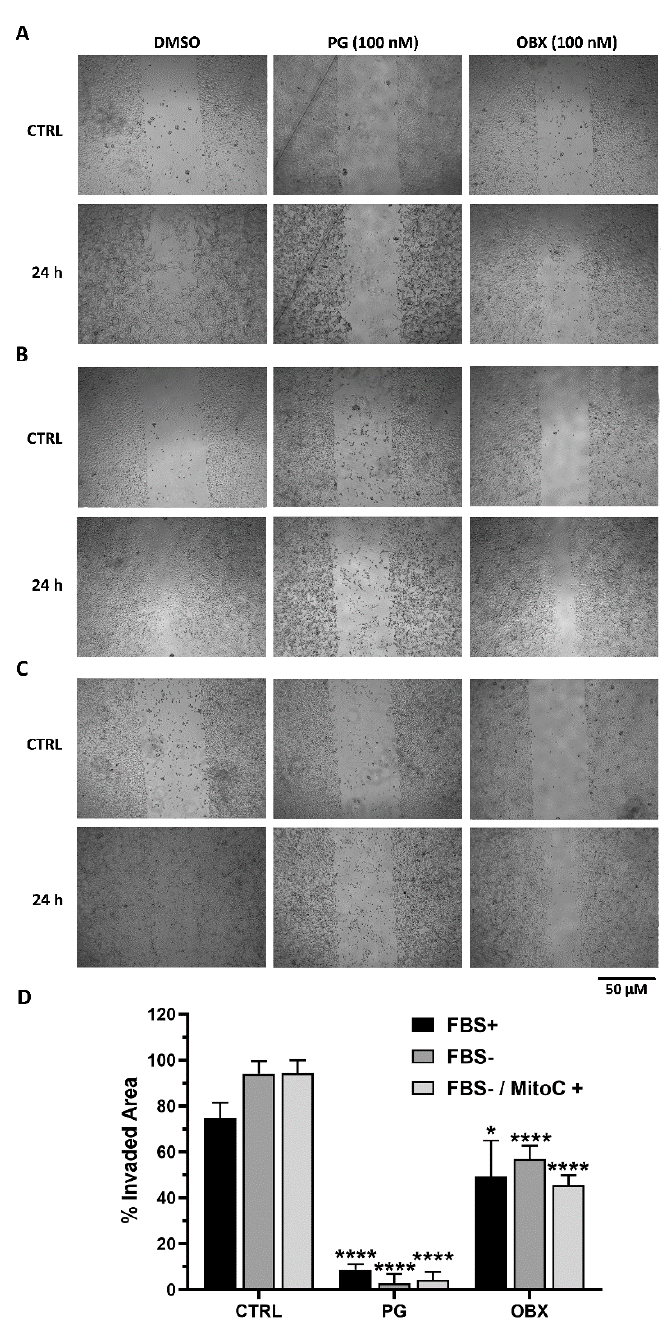
Figure 3. Effects of PG and OBX on B16F10 cell migration. The wound-healing assay was performed in three conditions: complete media with serum (FBS+) ( A ), serum-deprived (FBS-) ( B ) and serum- deprived plus mitomycin (FBS-/MitoC+) treatment ( C ). Cells were treated with 200 nM of PG or OBX for 24 h. Representative images of three independent replicates are shown. ( D ) Quantification of the % invaded area after 24 h of PG and OBX treatment. Figure shows mean ± SD. Statistical differences from control (CTRL) are shown as **** p < 0.0001 and * p <